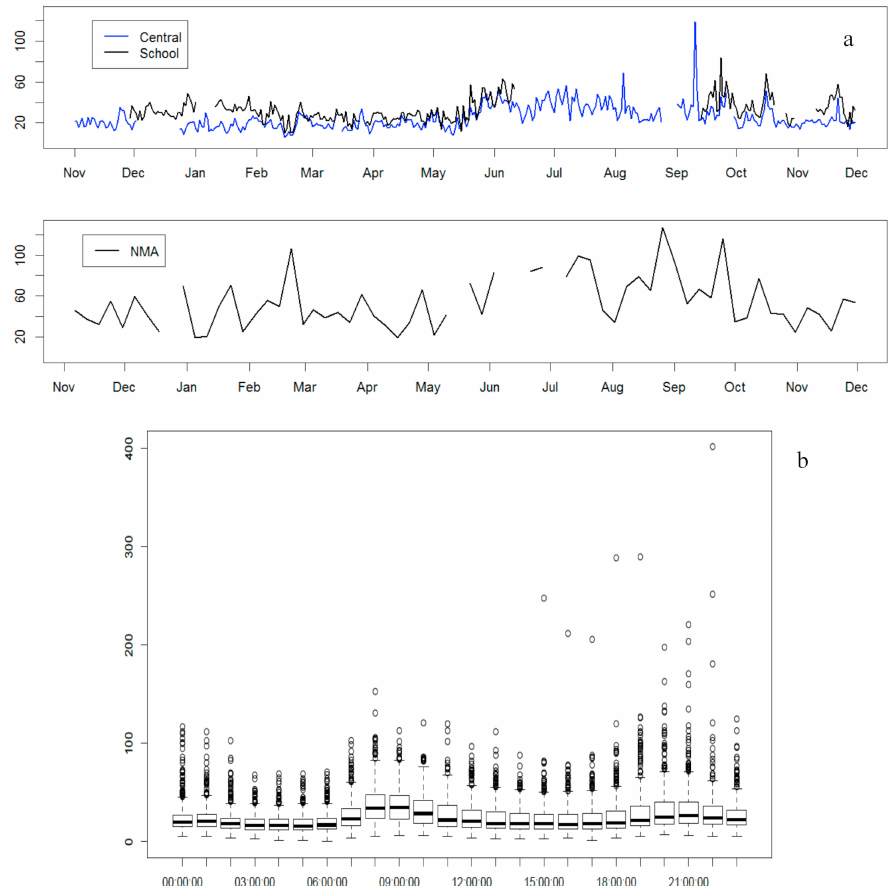
Figure 3. ( a ) Line graph of PM2.5 concentration ( µ g / m 3 ) trend during all seasonality (i) during August 2016 through December 2017 (US Embassy sites: Blue line—Central and Black line—School) and (ii) during November 2015–November 2016 (NMA—Met O ffi ce) site) in Addis Ababa. ( b ) Diurnal pattern of the concentration of PM 2.5 (given in µ g / m 3 ) for two US Embassy sites, from August 2016– December 2017, in Addis